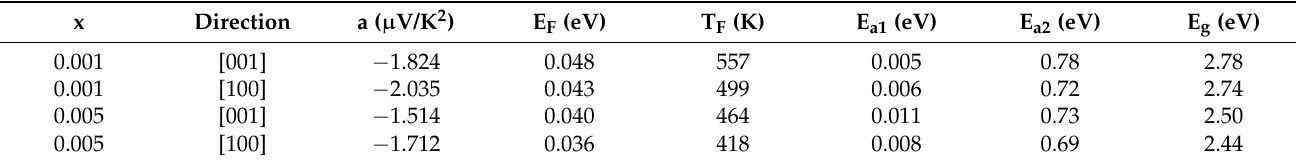
Table 2. Electrical parameters of PNMWO single crystals.